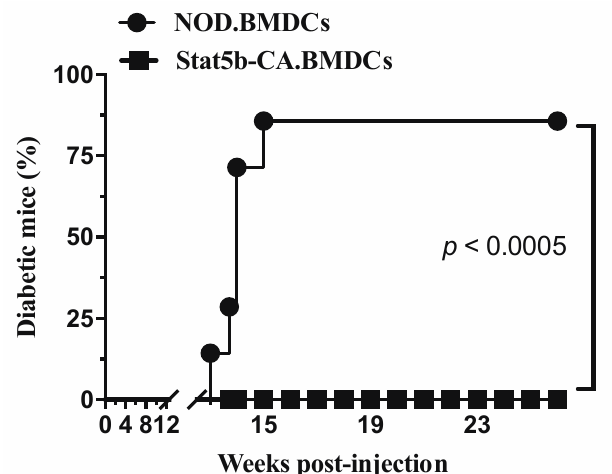
Figure 3. Inhibition of diabetes development by Stat5b-CA.BMDC treatment. Female 8- to 9-week-old NOD mice (7 mice per group) received one i.v. injection of BMDCs (10 7 cells / mouse) derived from NOD or NOD.CD11c Stat5b-CA mice. The animals were followed for diabetes development until 36 weeks (26 weeks post-injection) of age. For comparison of diabetes incidence between different groups, statistical analysis was performed with the Gehan–Breslow–Wilcoxon test .